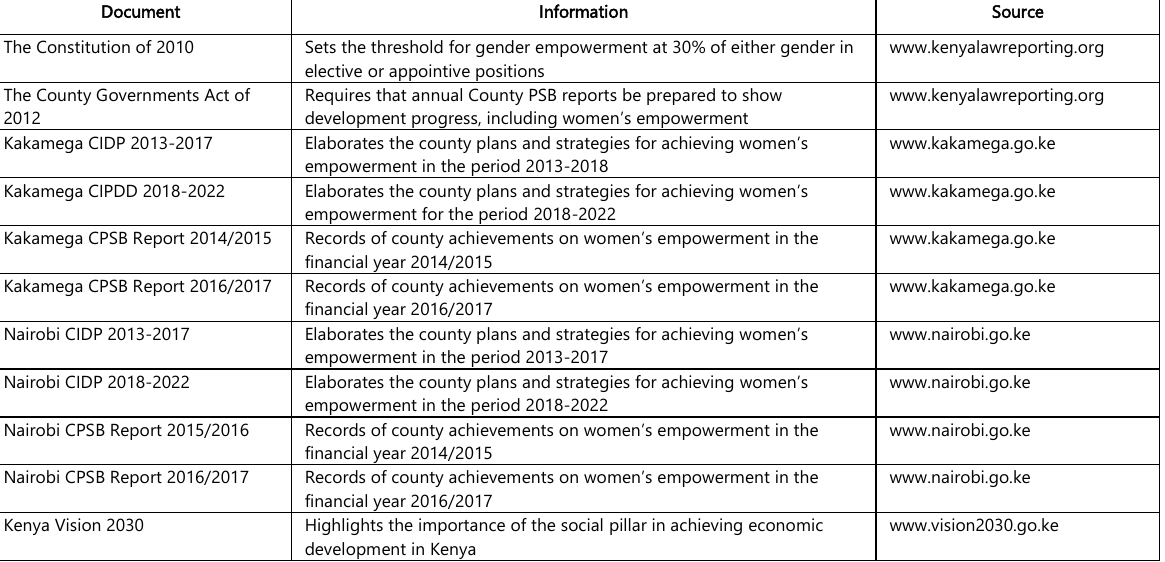
Table 1: Key Documents Consulted (Source: Authors’